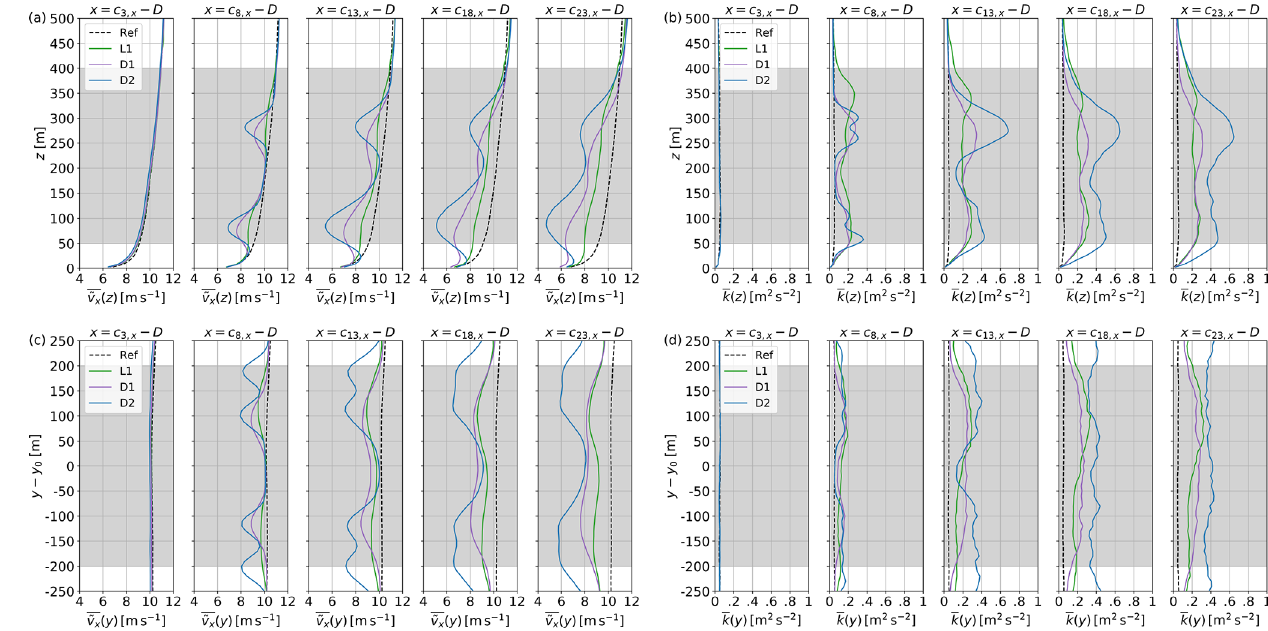
Figure 14. Mean profiles of streamwise wind velocity (cid:101) v x and turbulent kinetic energy k through the central park column ( x = 2000m) for the AWE parks L1, D1, and D2. The vertical (a, b) and horizontal (c, d) profiles are shown one diameter D upstream of the trajectory centre c i of the five AWE systems. The black dashed lines show the precursor reference and the grey-shaded area the operation region of AWE